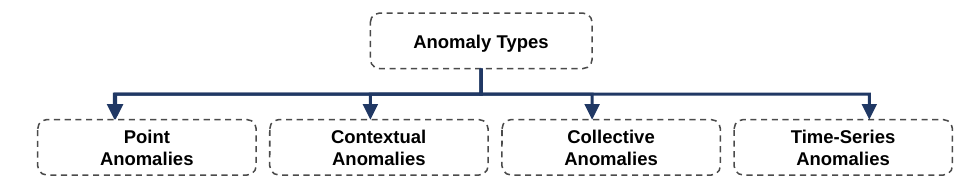
Figure 3. Taxonomy of big data anomaly types